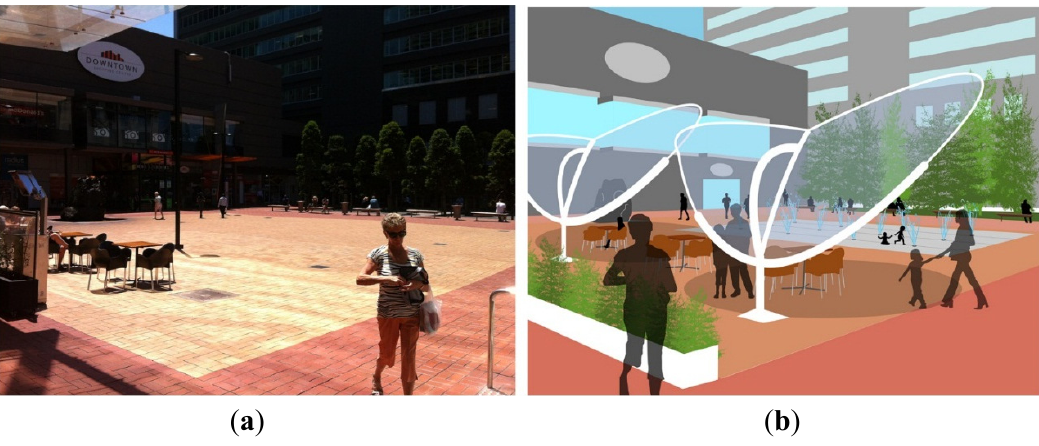
Figure 1. Conceptual intervention in Queen Elizabeth Square ( a ) Existing square; ( b ) Square post bioclimatic intervention. Source: Author’s